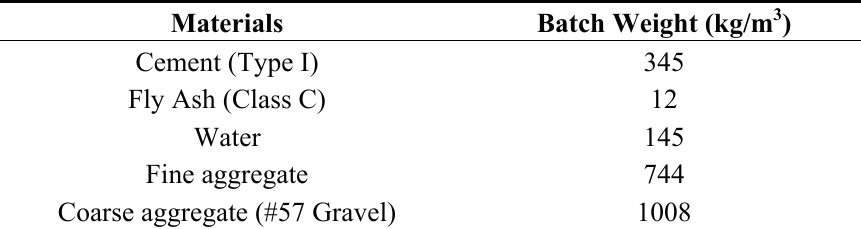
Table 1. Summary of the PCC mixture design used for the